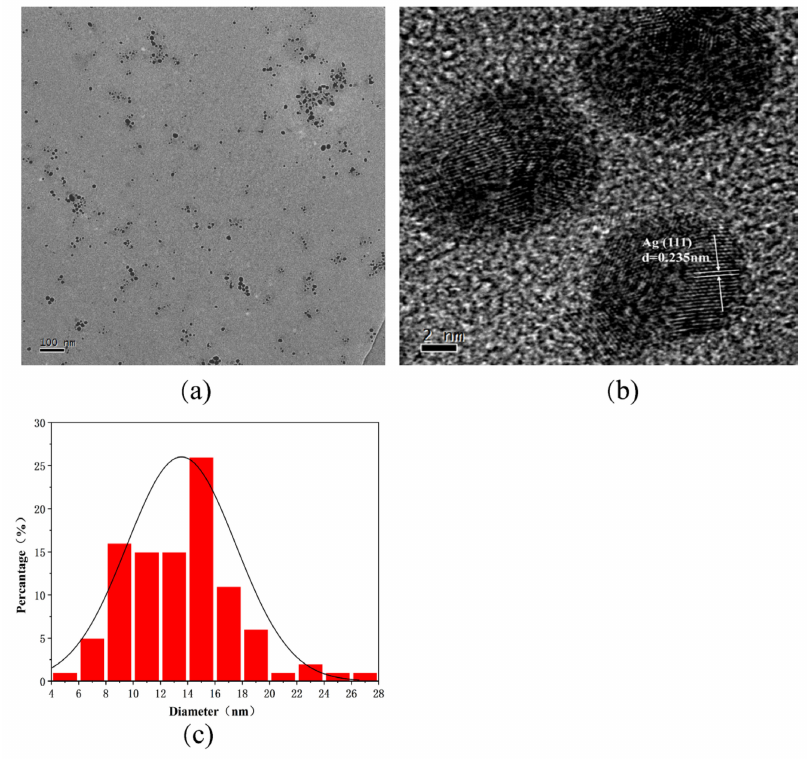
Figure 3. ( a ) TEM image of R-AgNPs, ( b ) HR-TEM images of the R-AgNPs, ( c ) histograms of silver nanoparticles in